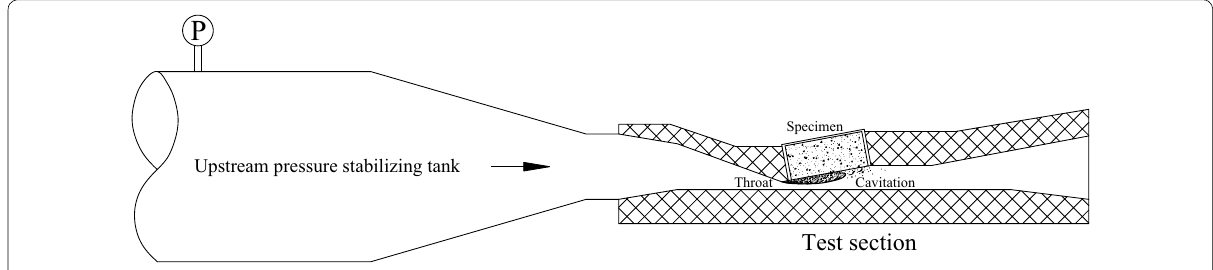
Fig. 2 Test device for cavitation erosion.